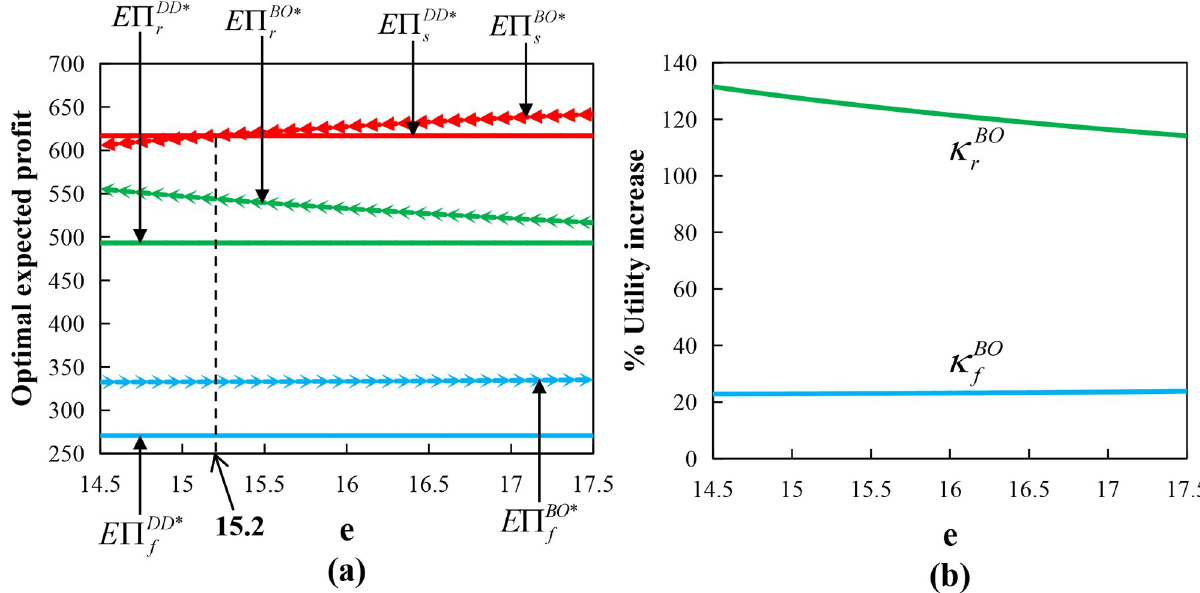
Fig 5. Impact of option exercise price under bidirectional option with wholesale price